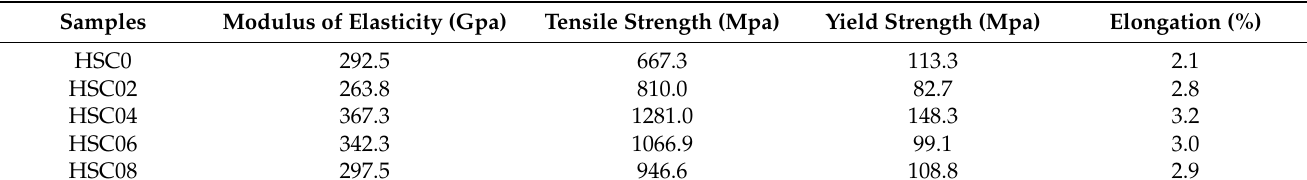
Table 5. Tensile performance parameters of the coating samples.